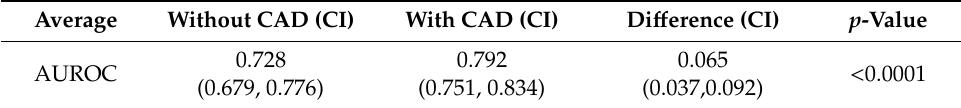
Table 3. The average AUROC of the readers.